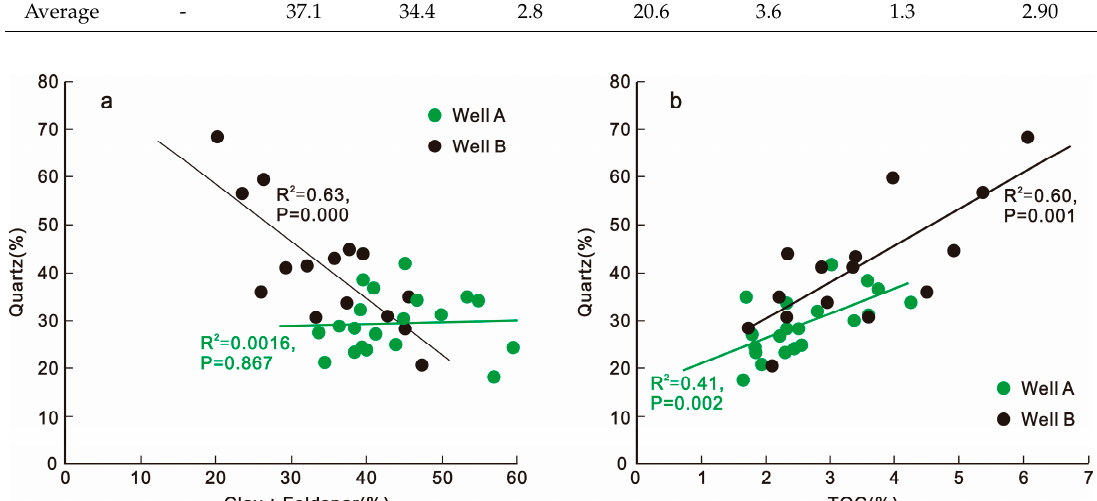
Figure 4. Correlation of quartz with clay + feldspar and TOC in the Wufeng and Longmaxi Formations of the Upper Yangtze region. ( a ) Correlation of quartz with clay + feldspar; ( b ) Correlation of quartz with